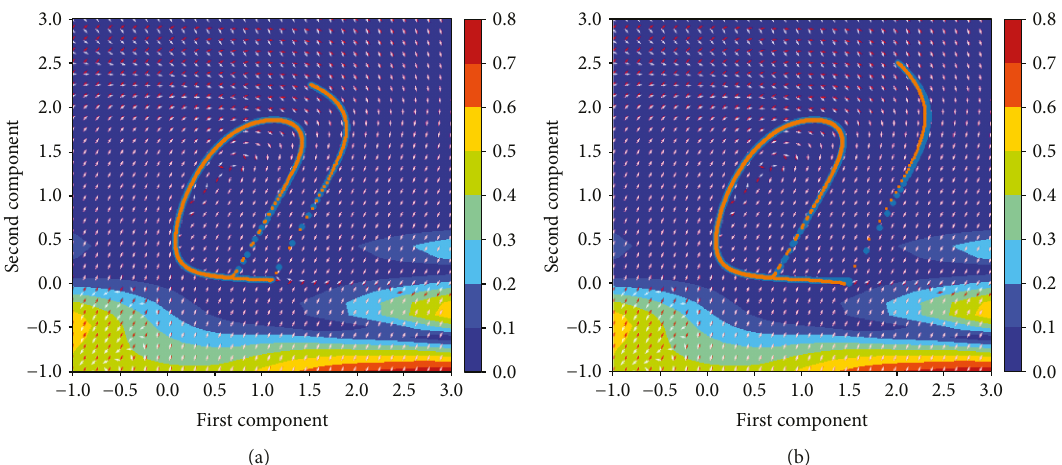
Figure 10: Stepwise error contour of the basic model on nonrational nonpolynomial case. (a) training data. (b) testing data. Blue dot: ground truth. Orange dot: prediction. White arrow: direction of target vector of ground truth. Red arrow: direction of target vector of prediction.